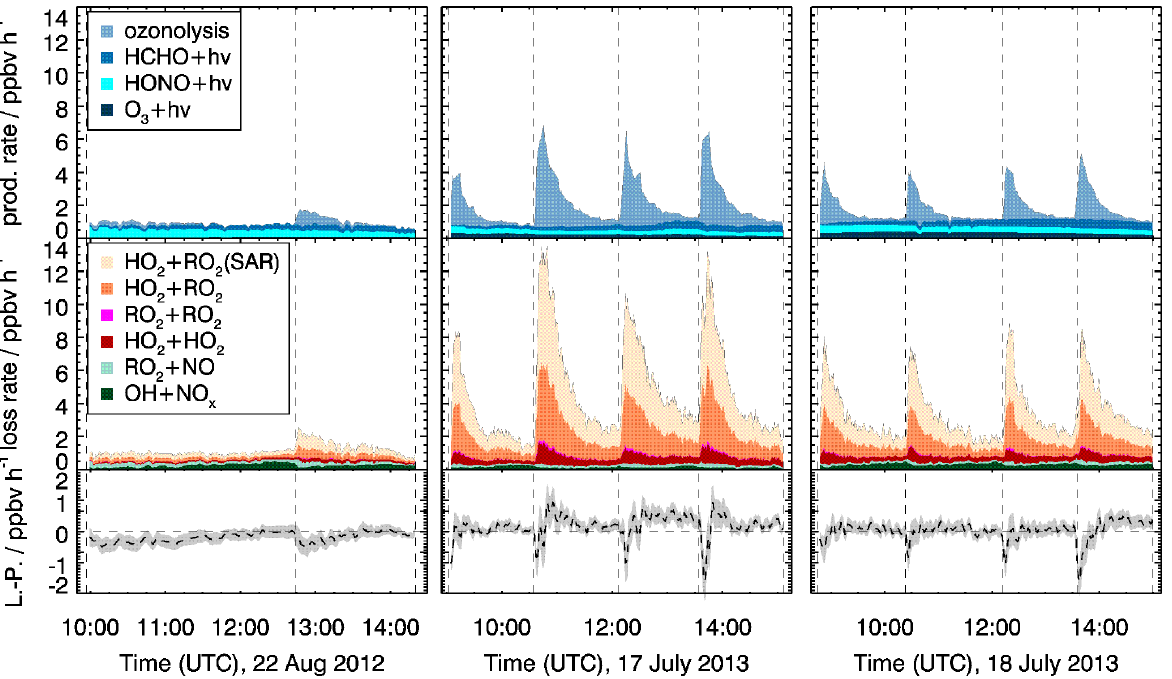
Figure 10. RO x primary production P (upper panels), termination L (middle panels) rates and their difference (lower panels). The rate constant of the reaction of MyO 2 with HO 2 was adjusted to minimize the difference between radical production and destruction (see text for more explanation). The HO 2 + RO 2 (SAR) shows the additional radical loss if the unadjusted reaction rate constant is applied. In the bottom row, the lines show the difference between radical destruction and production ( L − P ), with the adjusted rate constant of the reaction of MyO 2 with HO 2 . Grey areas in the lower panels give the uncertainty of L − P